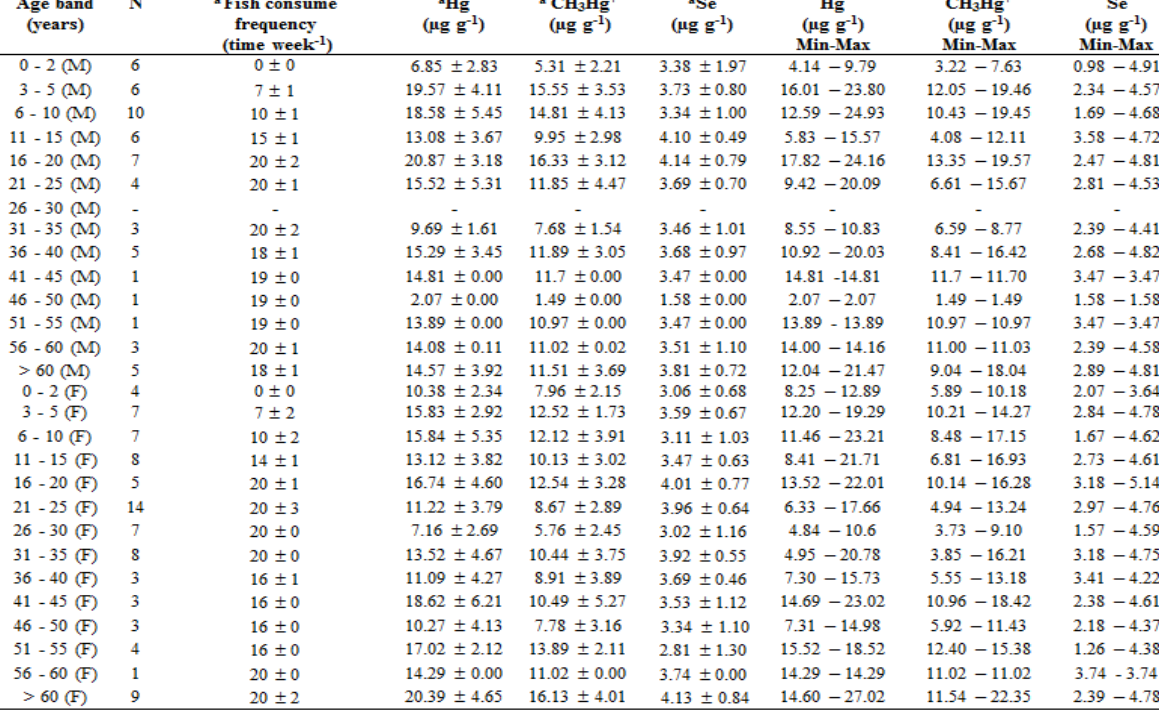
Table 1: Results of Hg, CH 3 Hg + , Se concentration in hair samples and fish consume frequency, for age band; of people residents in Itaituba municipality - Barreiras community (area impacted by gold mining underground), belonging to the Tapajós basin, Pará state (Amazon, Brazil).